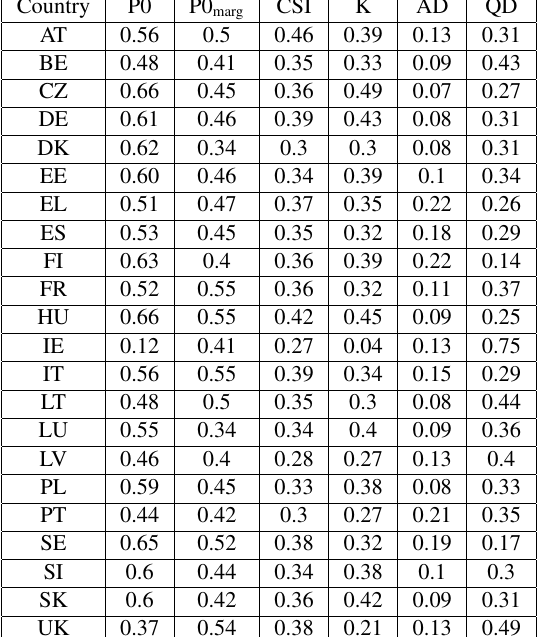
Table 6. Global accuracy indexes for each